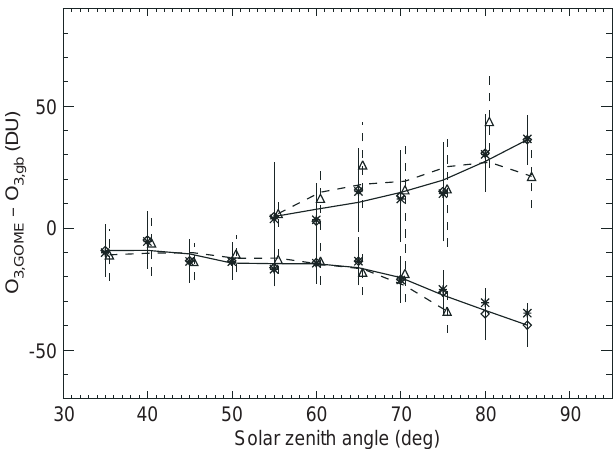
Fig. 7. Deviation of GOME total ozone from ground-based values averaged in 5-degree SZA intervals in July 1996 ( lower set of curves ) and in March 1997 ( upper set of curves ). Diamonds ( solid line ): GUV data averaged over (cid:139)3 h (3-point smoothing); asterisks : GUV data averaged over (cid:139)1 h. Triangles ( dashed line ): Dobson data, in July with an allowed time o(cid:128)set of up to 6 h (3-point smoothing). Dobson data are o(cid:128)set in SZA by 0.5 (cid:176) for clarity reasons